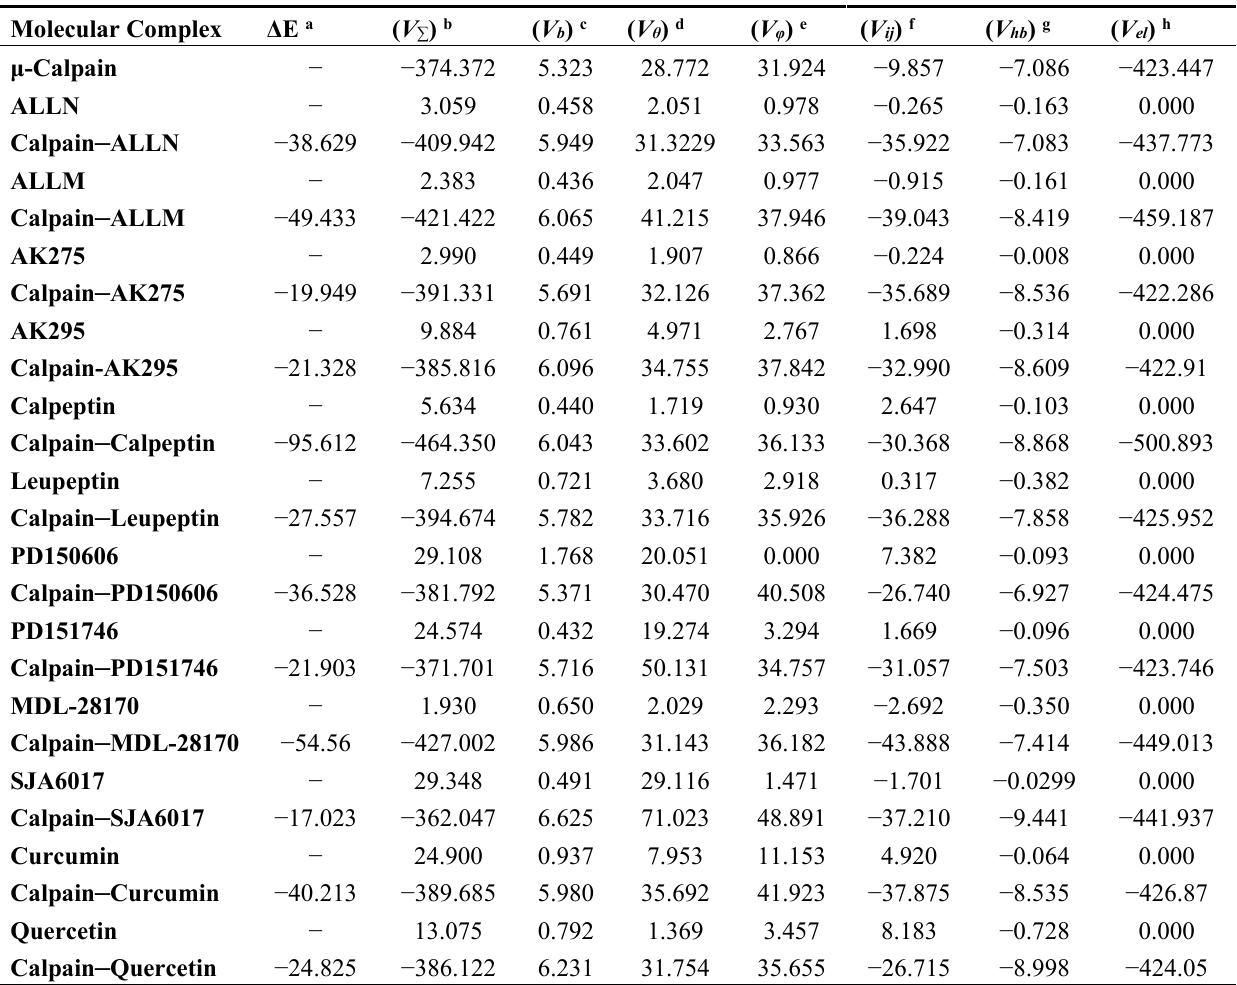
Table 1. Inherent energy attributes representing the molecular assemblies modeled using static lattice atomistic simulations in vacuum.